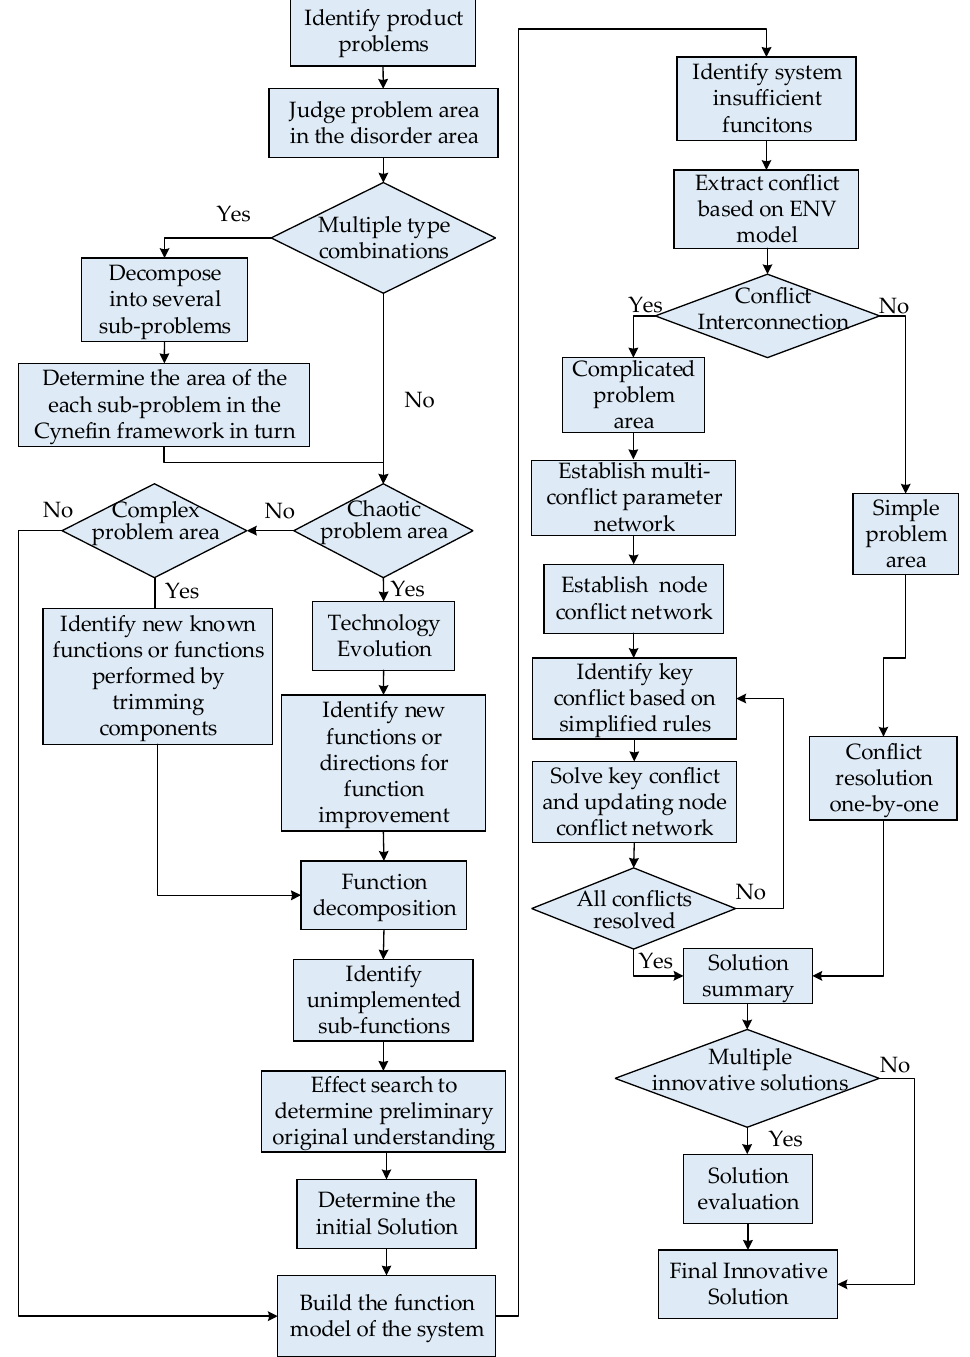
Figure 16. Problem-solving methodology for product innovation under the Cynefin Framework.